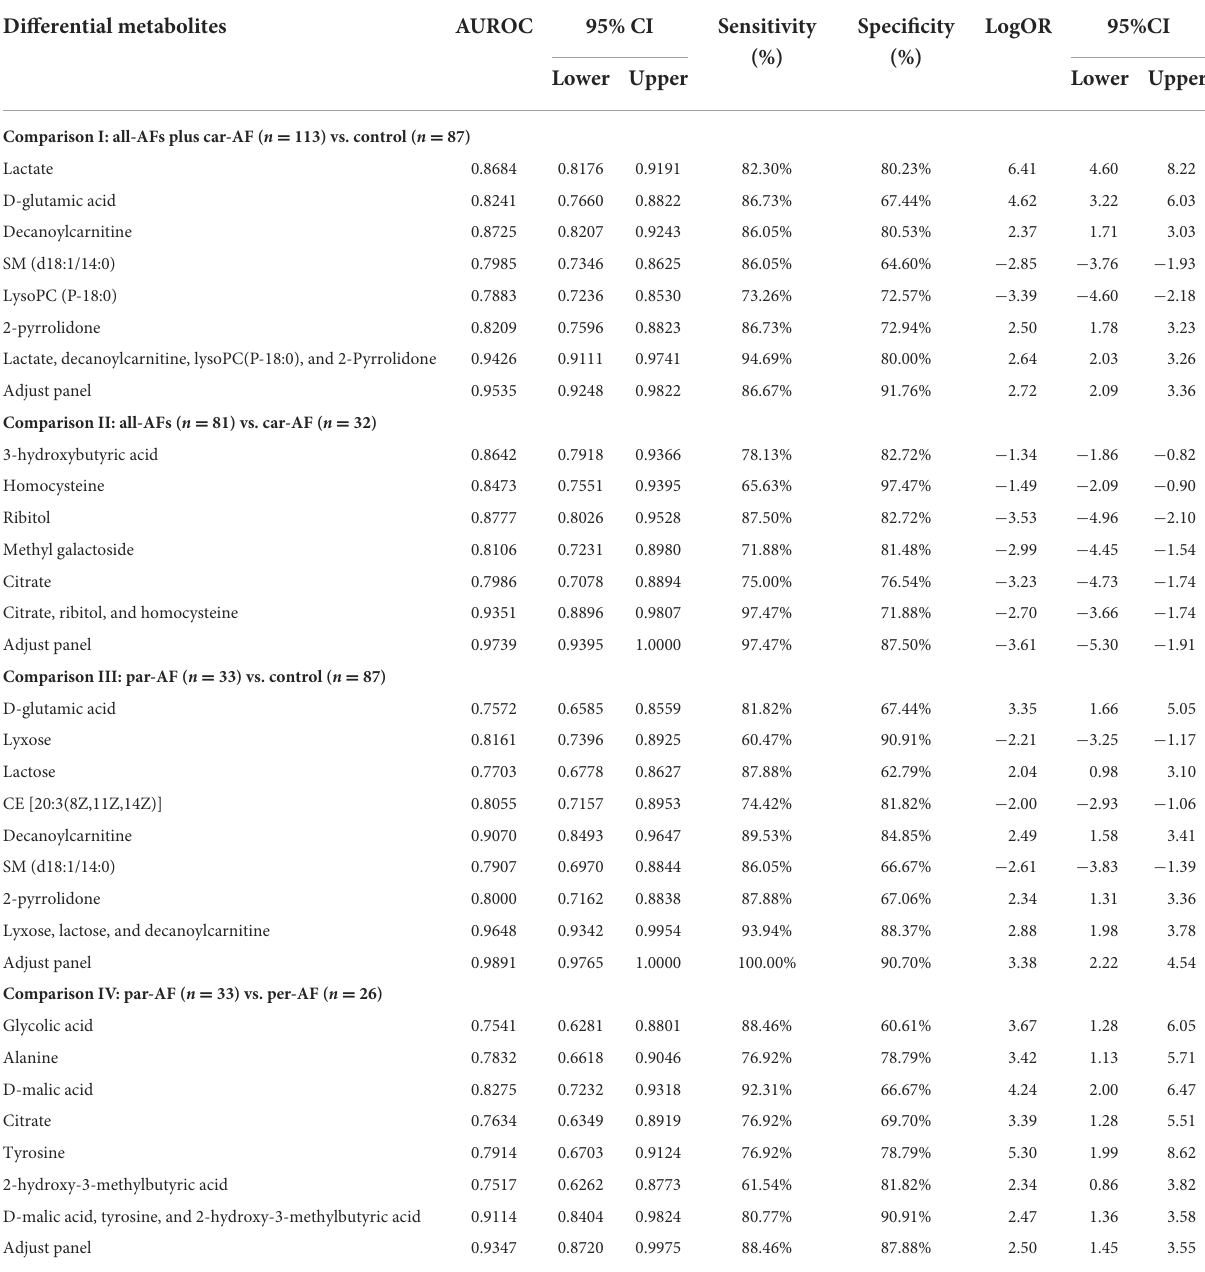
TABLE 4 Statistical analysis of diagnostic biomarkers: Discovery